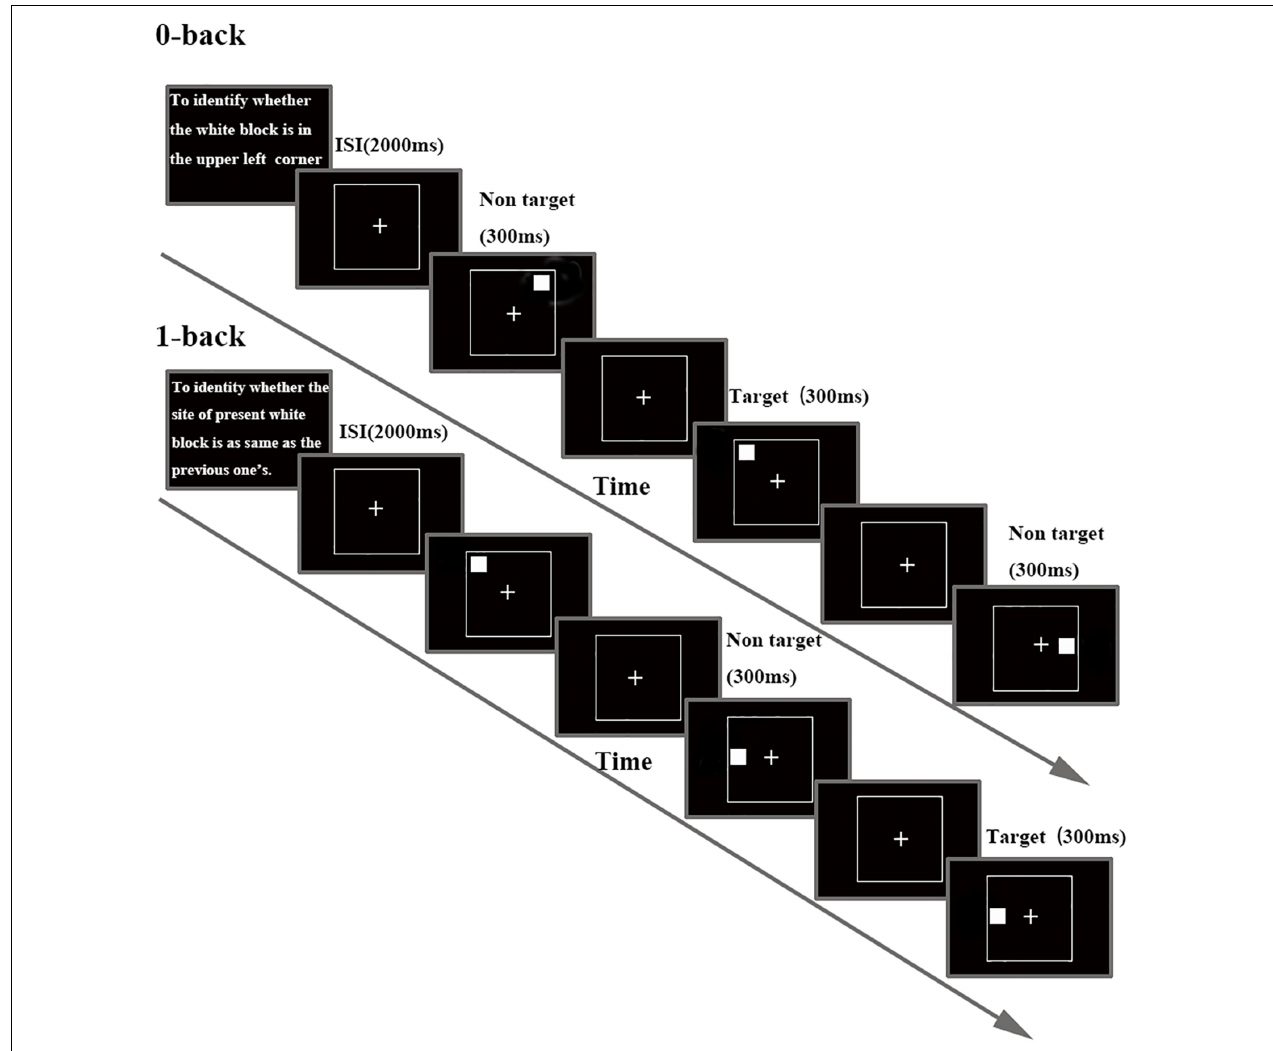
FIGURE 1 | Schematic diagram of the N-back task, separately for each task load. Details about timing for stimulus and inter stimulus interval (ISI) are included.